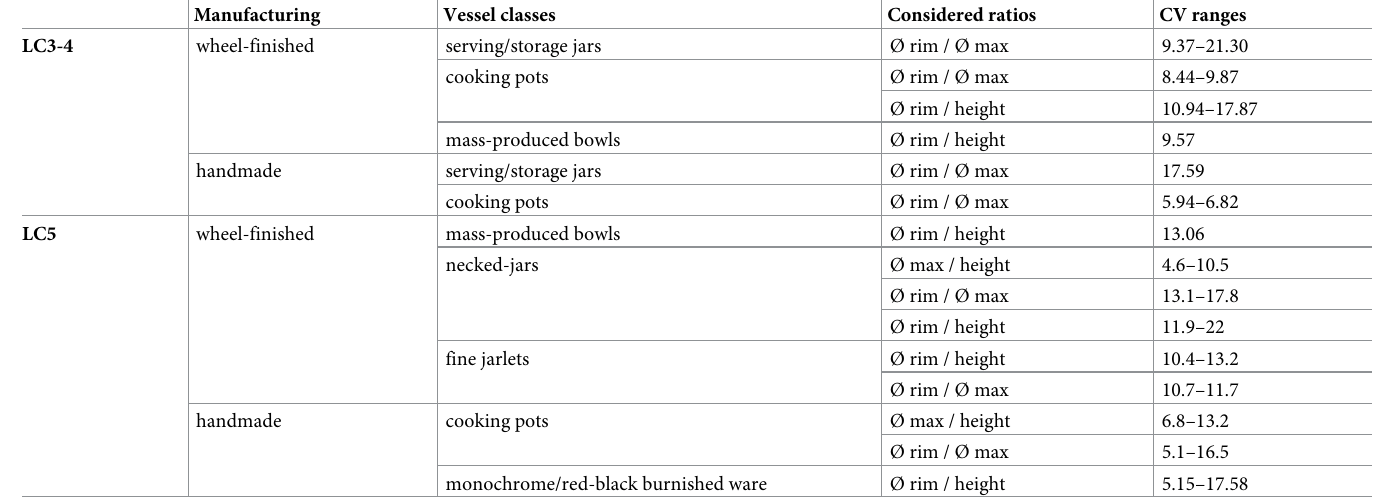
Table 1. Coefficient of variations (CV) calculated on LC3-4 to LC5 classes of vessels [64, 69].